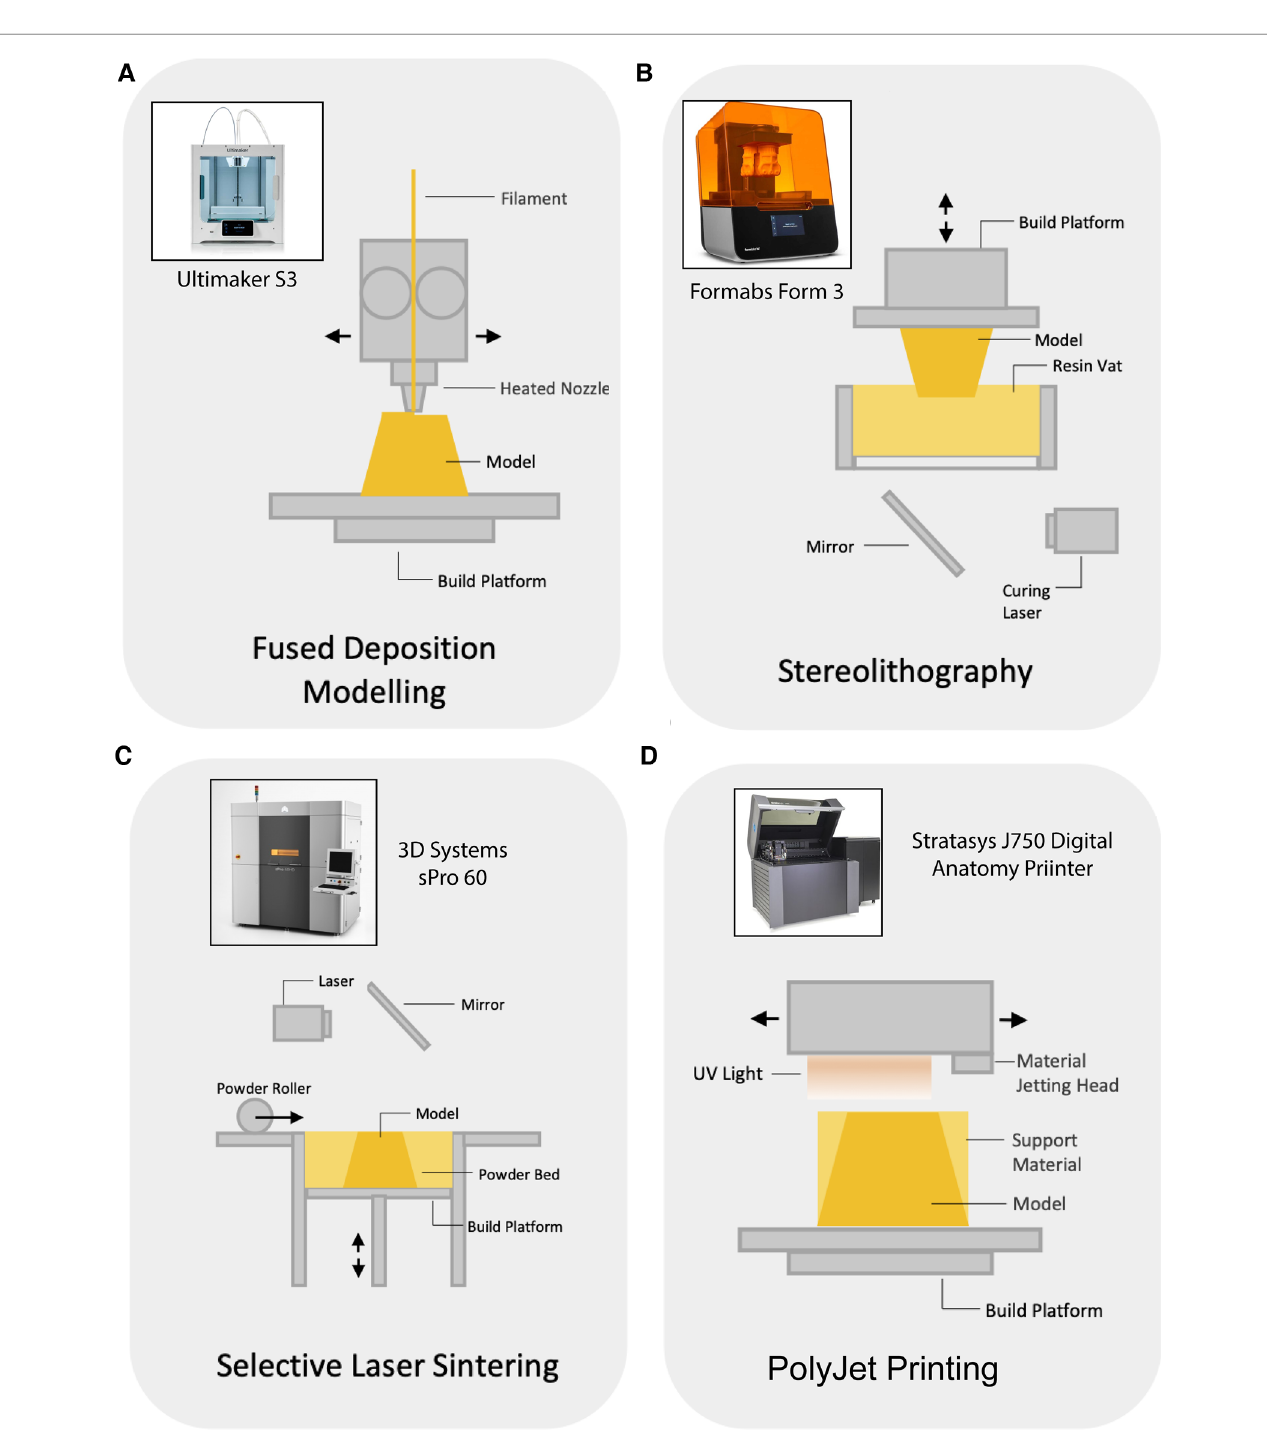
FIGURE 2 Schematic representation of tested 3D printing modalities. ( A ) Fused Deposition Modelling (FDM) – Common and least expensive, FDM printers heat and extrude a fi lament through a printhead on to a bed that descends with each layer (27). ( B ) Stereolithography (SLA) – A vat of photopolymer resin sits under a downfacing print plate which rests on the surface of the resin, the printer then uses UV laser to cure and harden a layer of the resin which is then lifted out of the resin vat in preparation for the next layer (27). ( C ) Selective Laser Sintering (SLS) – Thin layers of metal, ceramic, or polymeric powder are laser sintered to bind them together, a new layer of powder is applied and the process is repeated (27). ( D ) PolyJet printing – Print head projects particles of liquid photopolymer which is cured with ultraviolet light cured in layers and is able to produce multiple colours and materials within a single model